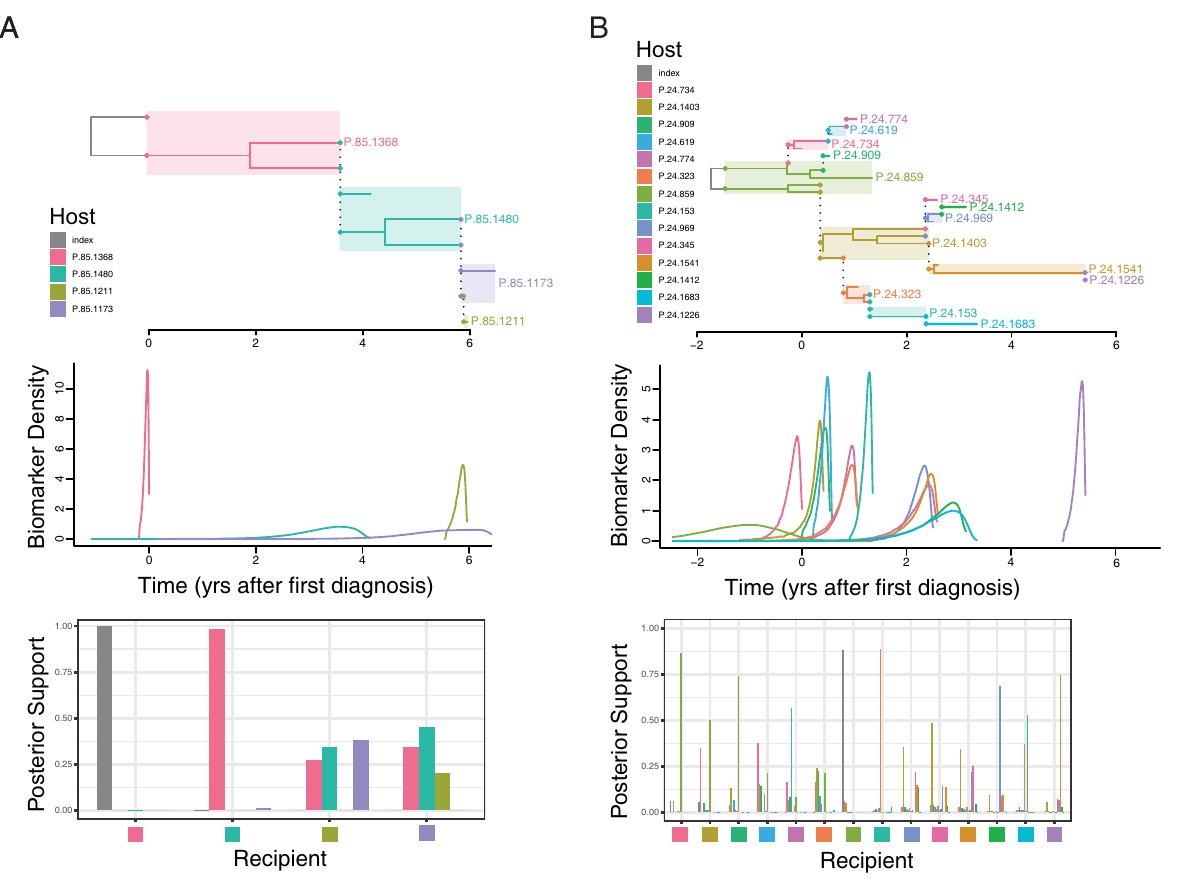
Fig 8. Transmission History Inference on Real HIV Transmission Clusters. Examples of a smaller, simple transmission history (A) and a larger, complex transmission history (B) from the Swedish HIV epidemic. The Top Panel in each transmission cluster shows the inferred maximum parent credibility tree. The Middle Panel shows the distributions of infection times inferred from biomarker values for each individual, using our 3-biomarker model applied to data that existed in a public health database. The Bottom Panel shows posterior support for each individual to be the source for each individual, with each colored square on the x-axis representing one individual and the height of the colored bars represent the posterior support for the corresponding individual to be their infector.